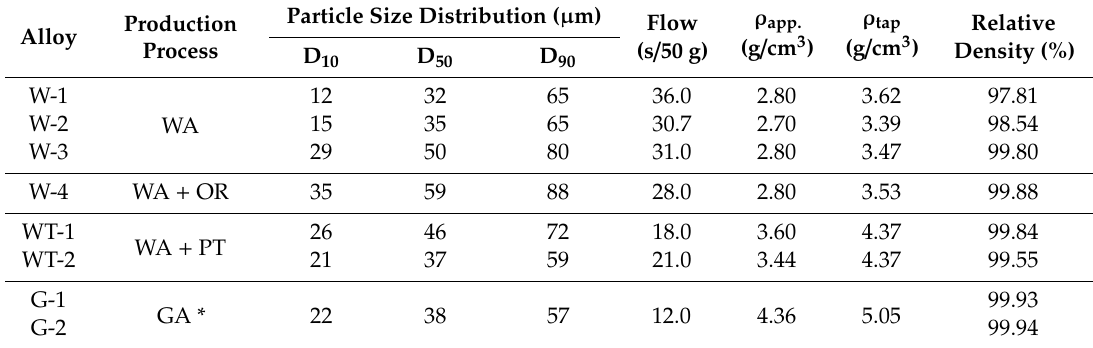
Powder properties and achieved relative density after L-PBF processing of the steels